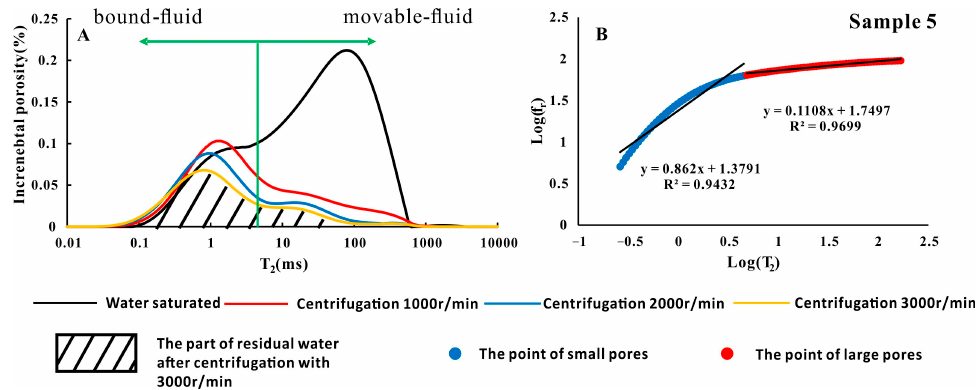
Table 5. Fractal Dimensions of the residual water from NMR in different centrifugal speeds. Sample